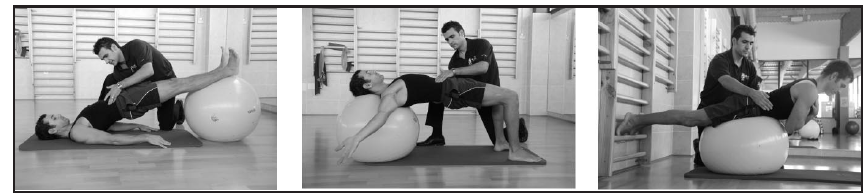
Figure 6. Improve isometric muscle resistance.